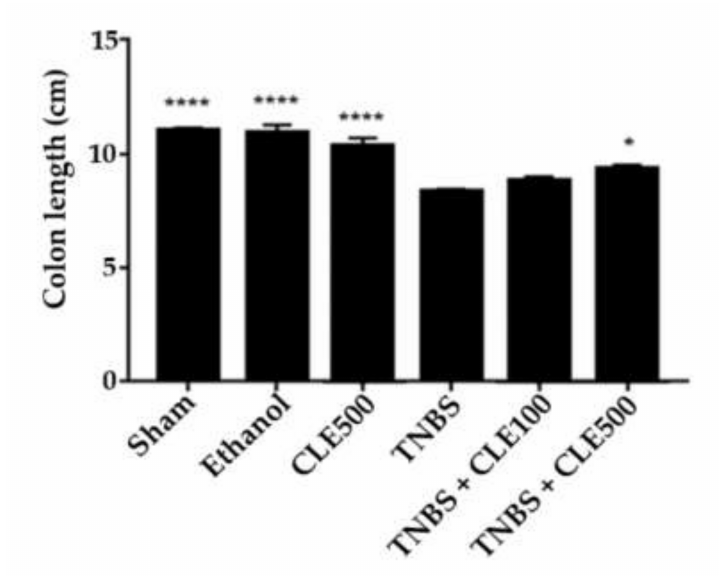
Figure 2. CLE influence on colon length in IBD context. Legend: One-way ANOVA and Tuckey’s post hoc test; * p < 0.1; **** p < 0.0001; in comparison to the TNBS group. Abbreviations: CLE, C. cardunculus L. extract; TNBS, 2,4,6-trinitrobenzene sulfonic acid. Fecal hemoglobin was quantified and then compared between all groups (Figure 3).